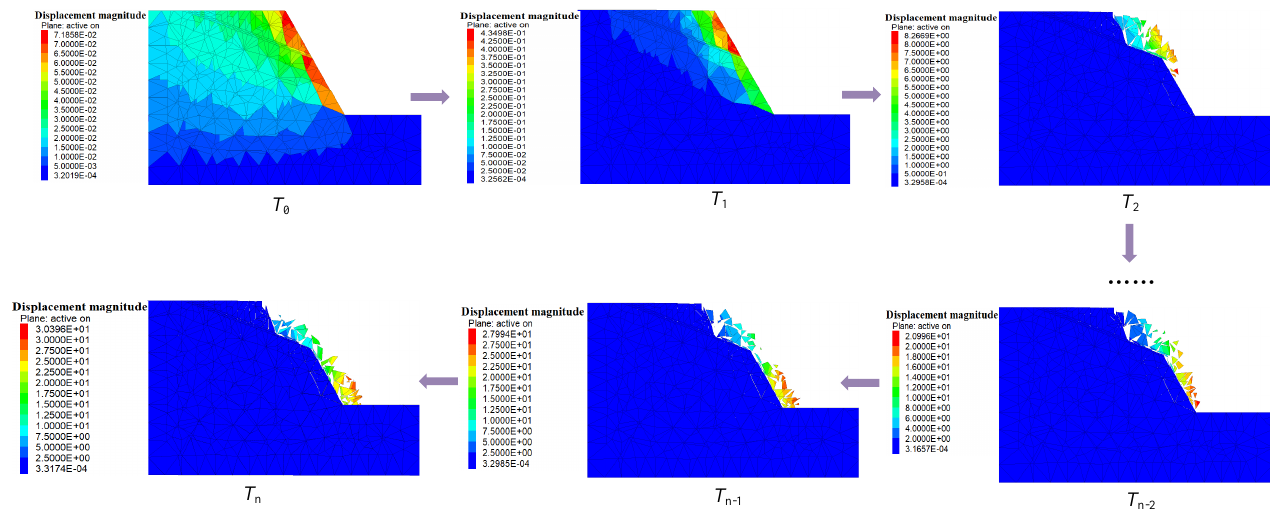
Figure 2. A simple illustration of a rock slope changing from stability to